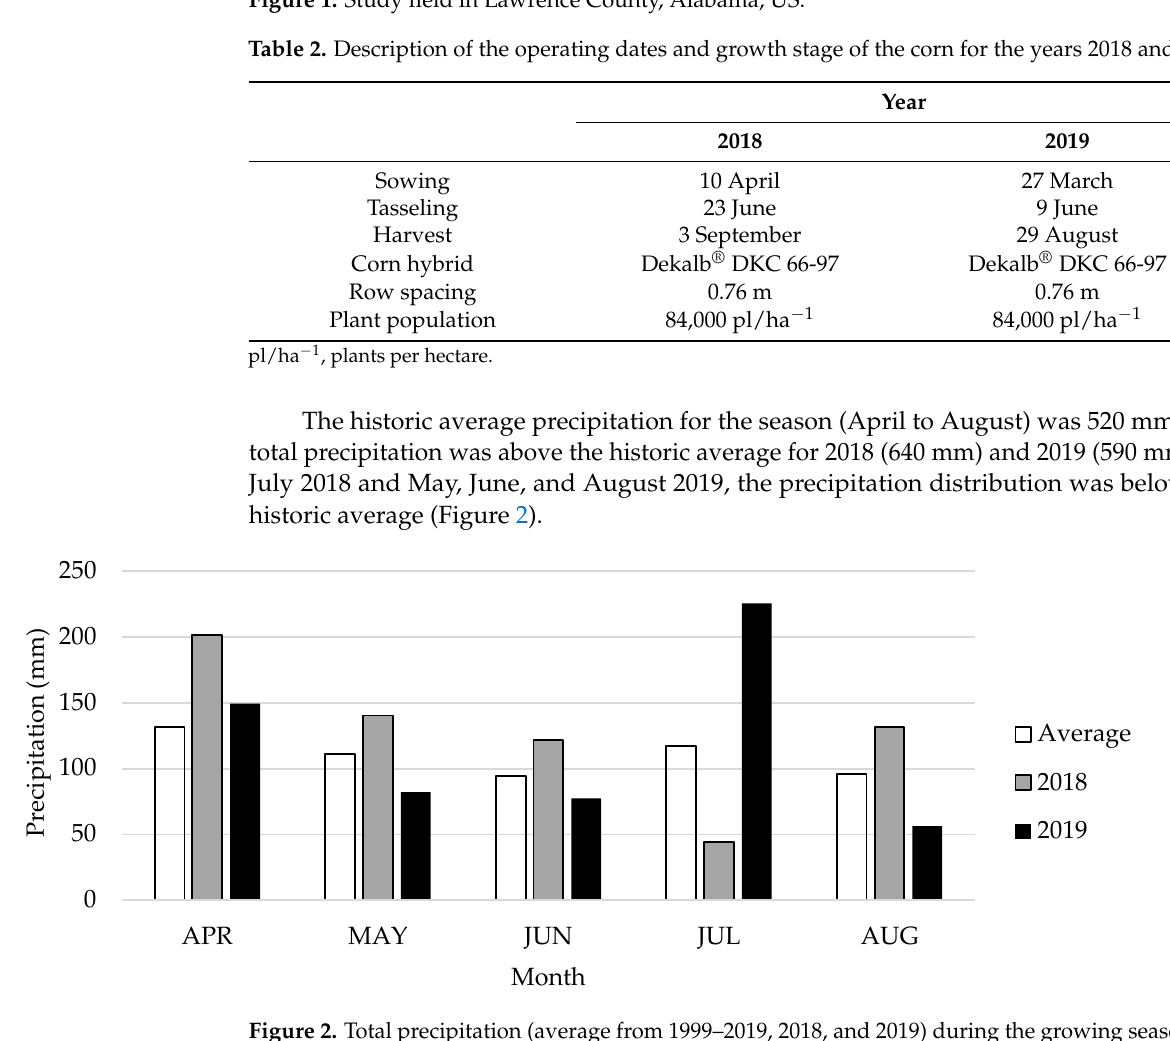
Figure 2. Total precipitation (average from 1999–2019, 2018, and 2019) during the growing seasons. A Vantage Pro 2 Plus weather station (model 6163, Davis Instruments, Hayward, CA, USA) located close to the field was used to record the precipitation data. Adapted from [42].